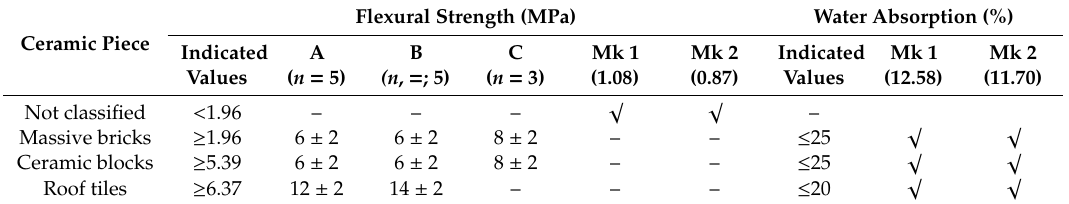
Table 5. Ceramic specifications based on flexural strength and water absorption [5,42,43]. Ceramic